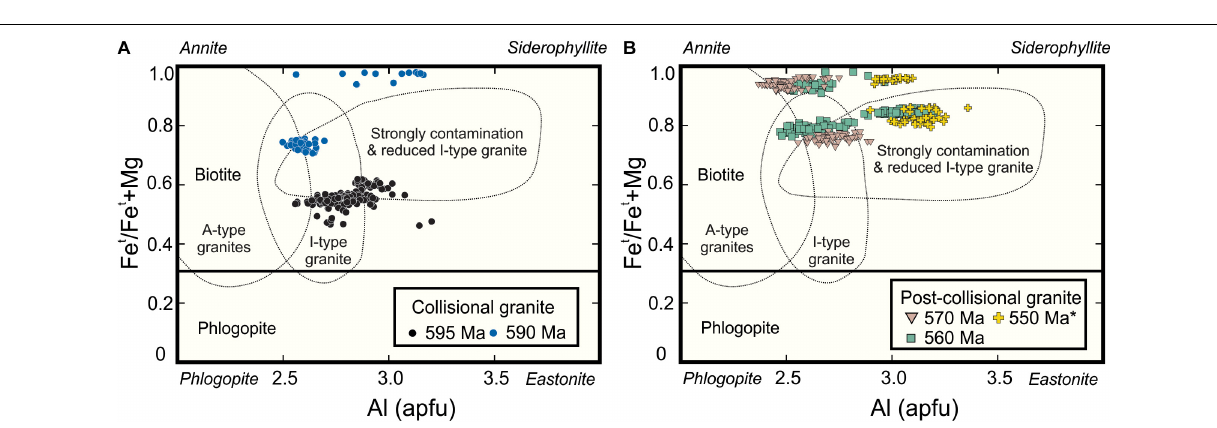
and the Moyto granites are reducing. In general, the